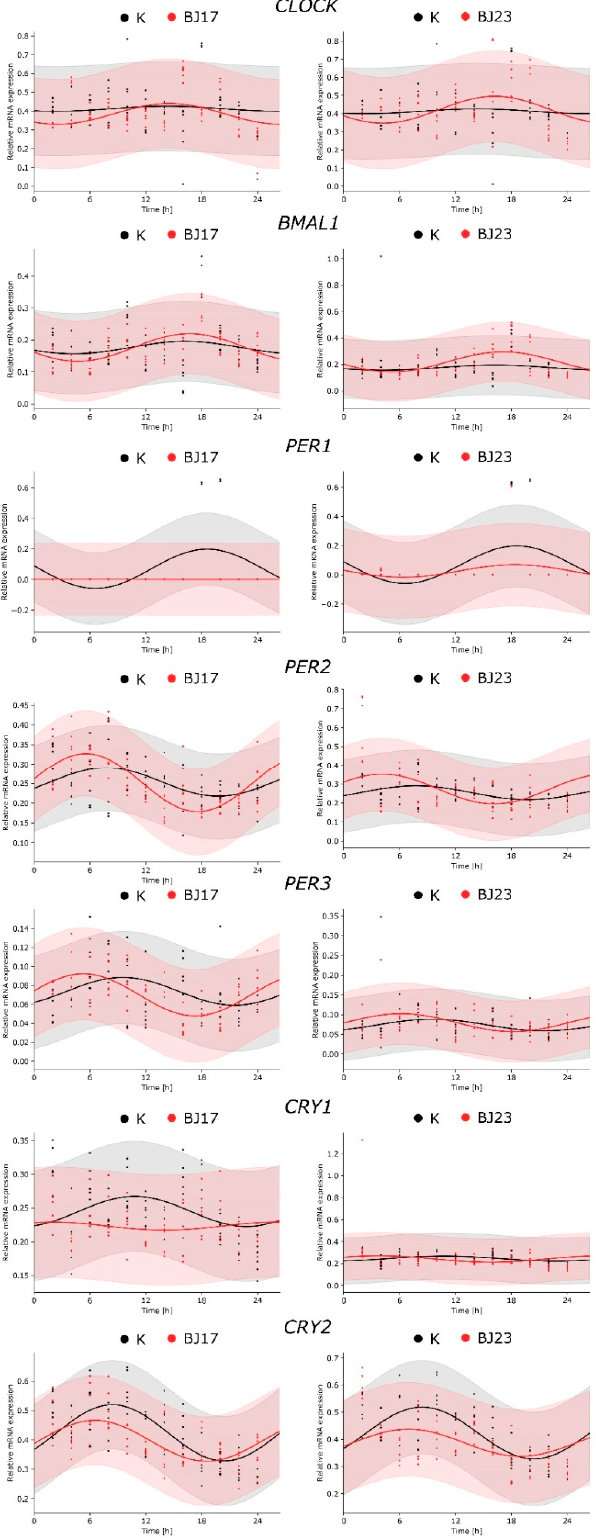
Figure 2. Comparison of circadian behavior of core clock gene expression between the